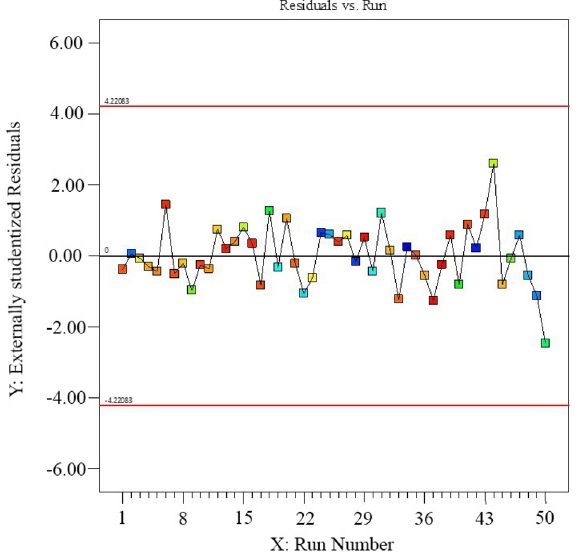
Figure 6. The plot of residual vs. runs for MB uptake capacity of the nanofibers adsorbent.